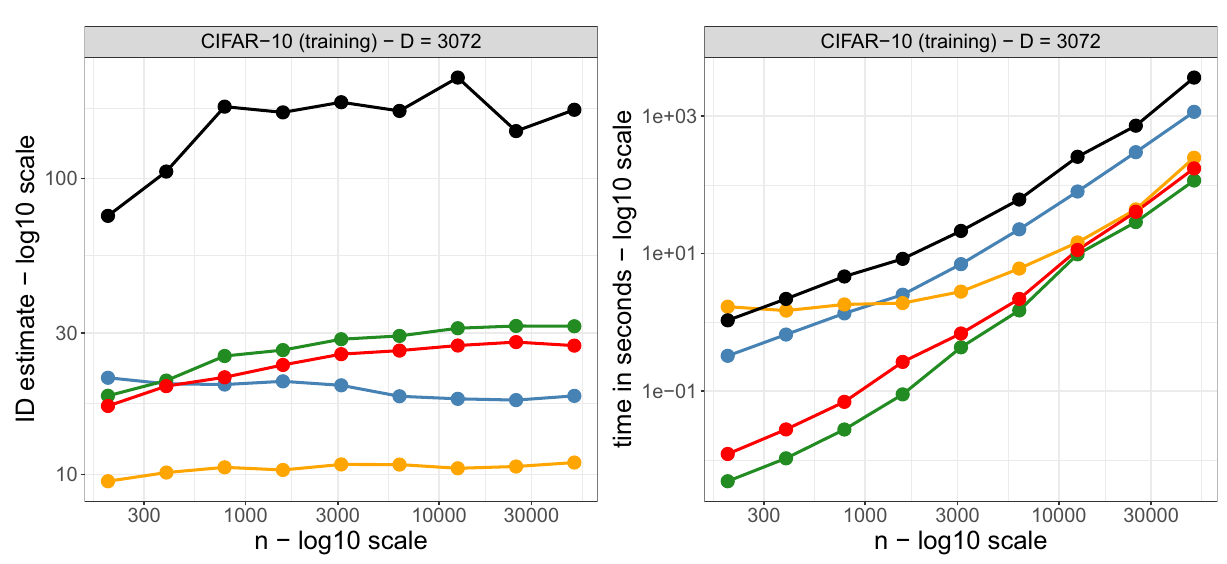
Figure 9. Trajectories of estimated id s (left panel) and elapsed times in seconds (right panel) obtained on the CIFAR-10 (training) dataset with DANCo , GeoMLE , ESS , TWO-NN , and Gride